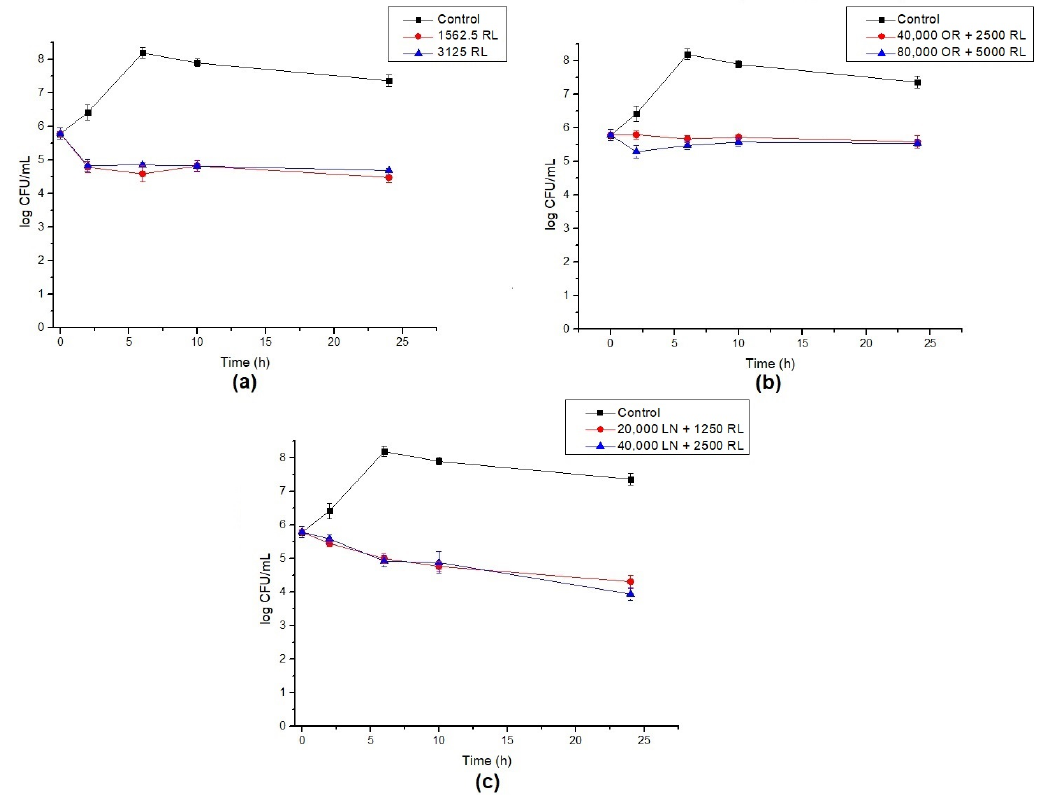
Figure 4. Log reduction in endospore germination after treatment with ( a ) RL, ( b ) OR + RL, and ( c ) LN + RL. Lines show the log CFU/mL for the control (black), 16× MIC (red), and 32× MIC (blue). Error bars show the standard deviation of at least three independent replicates.